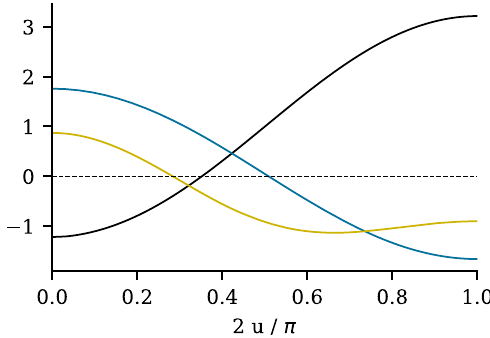
FIG. 11. Distribution of dipole (black), quadrupole (blue) and sextupole fields (yellow) for the example solution marked in Fig. 10. The optical functions are identical to those in Fig. 6.